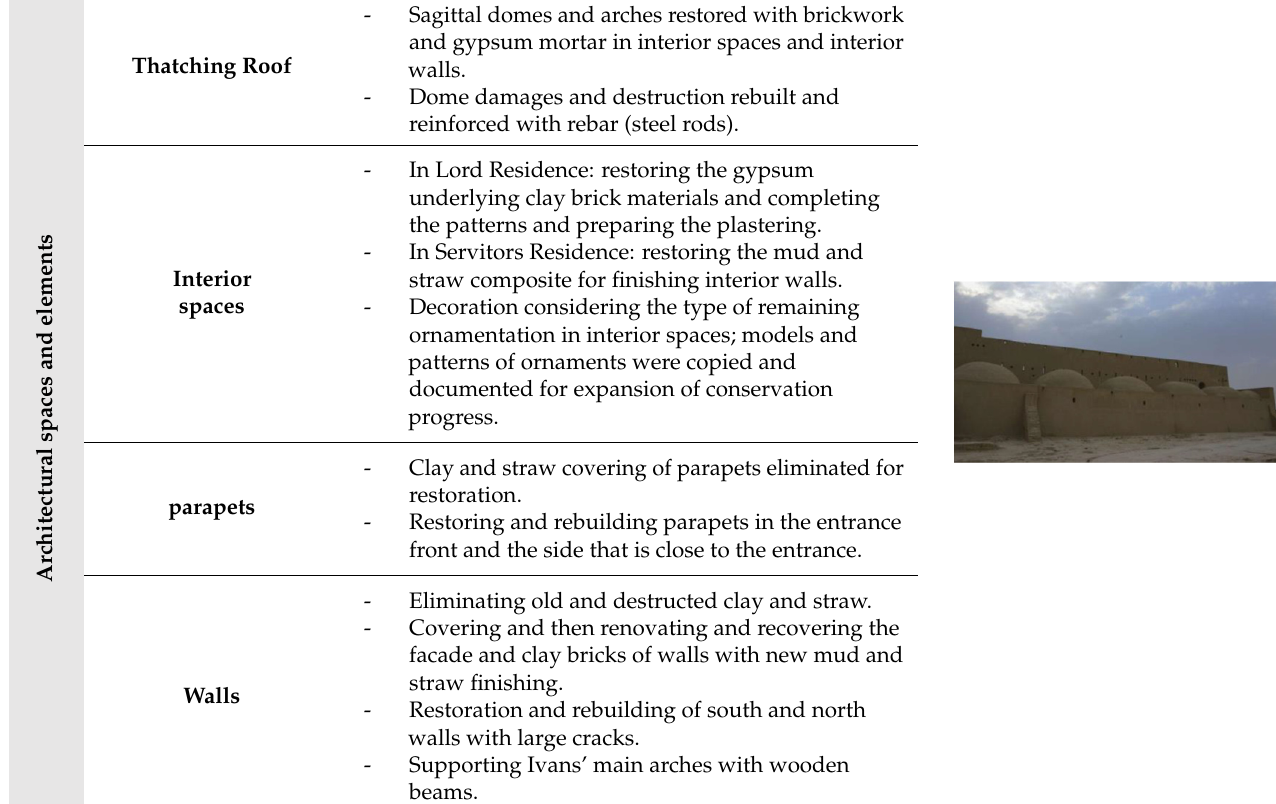
Table 5. Conservation plan for physical spaces (Mochi Castle).